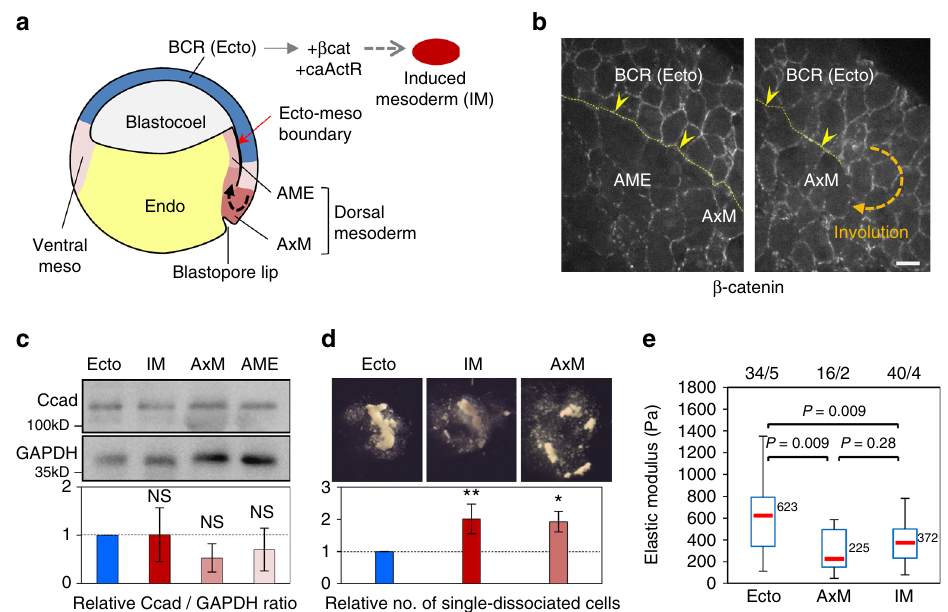
Fig. 2 Xenopus ectoderm and mesoderm and their adhesive and contractile properties. a Diagram of the early Xenopus gastrula indicating the regions used as the source for tissue explants. Induced mesoderm was produced by expression of β -catenin ( β -cat) and constitutively active Activin receptor (caActR) in the blastocoel roof ( BCR ). b Distribution of adhesive structures in the ectoderm blastocoel roof ( BCR or Ecto ), anterior mesendoderm ( AME ) and axial mesoderm ( AxM ) visualised by β -catenin immunostaining. The thin yellow dotted line and yellow arrowheads point to the mature ( left panel ) or nascent ( right panel ) ectoderm – mesoderm boundary. Scale bar, 20 µ m. See also Supplementary Fig. 1b ( c – e ). Characterisation of adhesive and contractile properties. c Total cadherin levels in dissected tissues determined by immunoblot and expressed as the relative ratio to GAPDH. Graph shows mean values from seven independent experiments. Error bars, s.d. NS: not signi fi cantly different from ectoderm, based on one-sided Student ’ s t -test. d Resistance to dissociation, measured as the number of single-dissociated cells, normalised as the ratio to ectoderm. Mean of four independent experiments. Individual comparisons were made using one-sided Student ’ s t -test. * P < 0.05; ** P < 0.01. Error bars, s.d. e Cortical tension. The elastic modulus of single cells was determined using AFM. The box plots show the interquartile range ( box limits ), median ( centre line and corresponding value), and min and max values without outliers ( whiskers ). Number of cells/experiments are indicated on top. Individual comparisons were done using Tukey ’ s HSD test after a signi fi cant one-way ANOVA ( P = 5.7e −